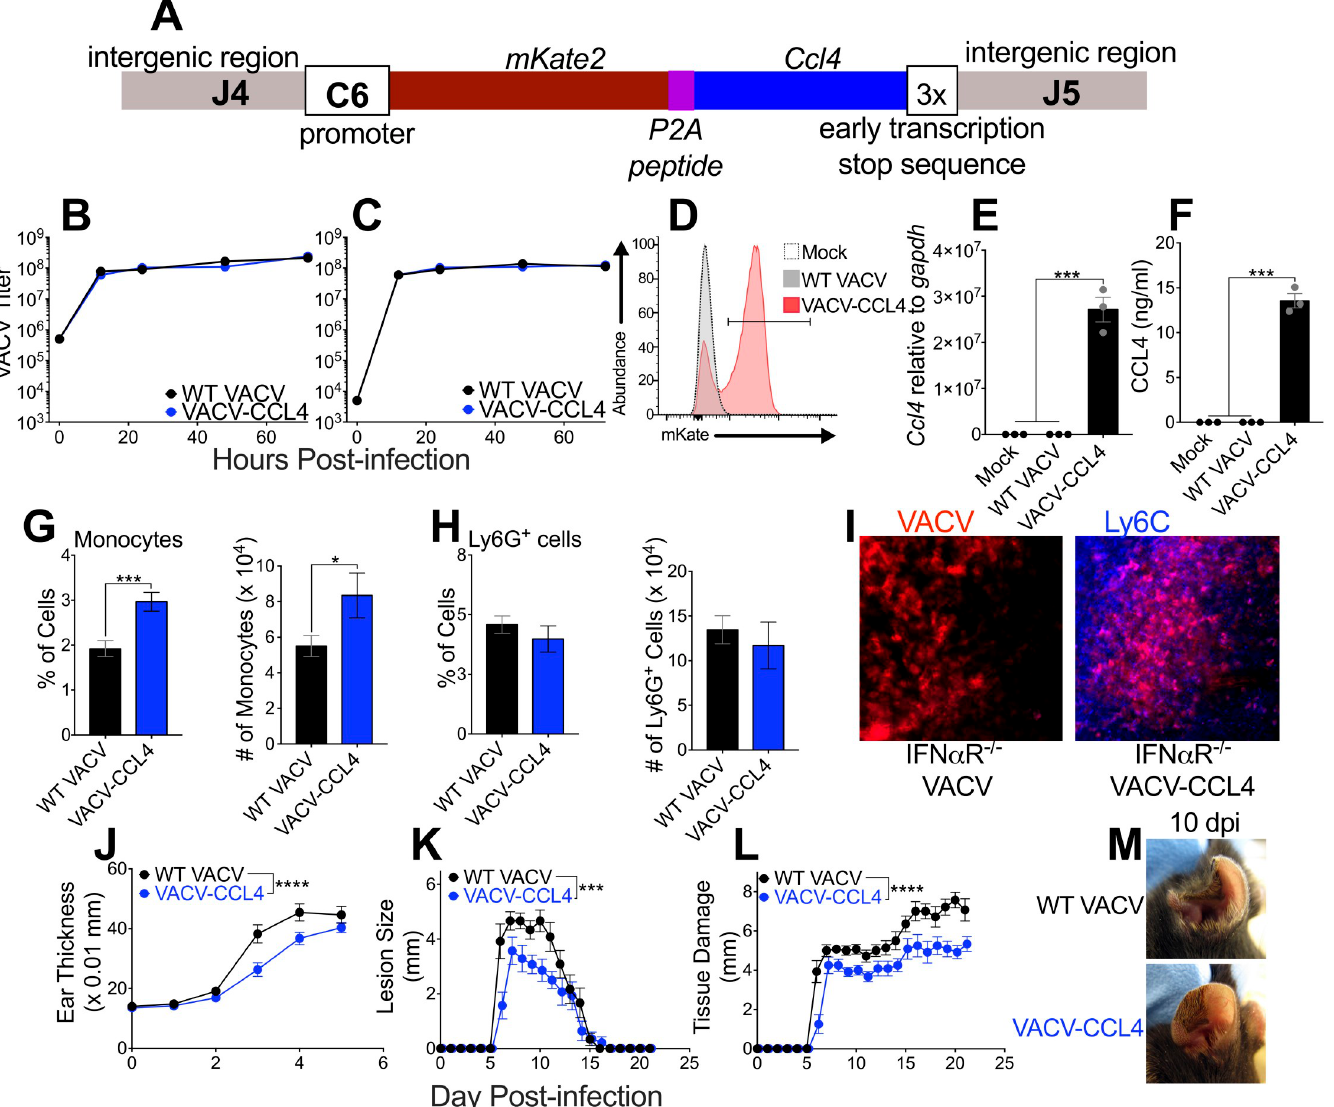
Fig 6. ccl4 expression restores inflammatory monocyte recruitment and ameliorates tissue damage. (A) Schematic of rVACV expressing ccl4 and mKate2. (B) Single step growth curve of wild-type VACV and VACV-CCL4 in 143B cells. (C) Multi-step growth curve of wild-type VACV and VACV-CCL4 in 143B cells. (D) Detection of mKate2 expression in 143B cells 6 hpi assayed using flow cytometry. (E) Expression of murine ccl4 in 143B cells 6 hpi measured by RT-qPCR. (F) Secretion of murine CCL4 from 143B cells 24 hpi measured using ELISA. (G) Monocyte recruitment into VACV-infected ears of IFN α R -/- mice 5 dpi assayed by flow cytometry, n = 4 mice per group. (H) Ly6G + cell recruitment into VACV-infected ears of IFN α R -/- mice 5 dpi measured by flow cytometry, n = 4 mice per group. (I) Immunofluorescence microscopy of IFN α R -/- ears 5 dpi with VACV-CCL4 or VACV-mCherry for monocyte localization (Ly6C-Blue) in relation to VACV-infected cells (mKate/mCherry- Red). (J-L) Tissue pathology of the ear pinnae of IFN α R -/- mice after intradermal infection with VACV; ear thickness (J), lesion size (K), or total tissue damage (L), n = 6–7 mice per group. (M) Representative pictures of ear pinnae of IFN α R -/- mice following intradermal VACV infection.